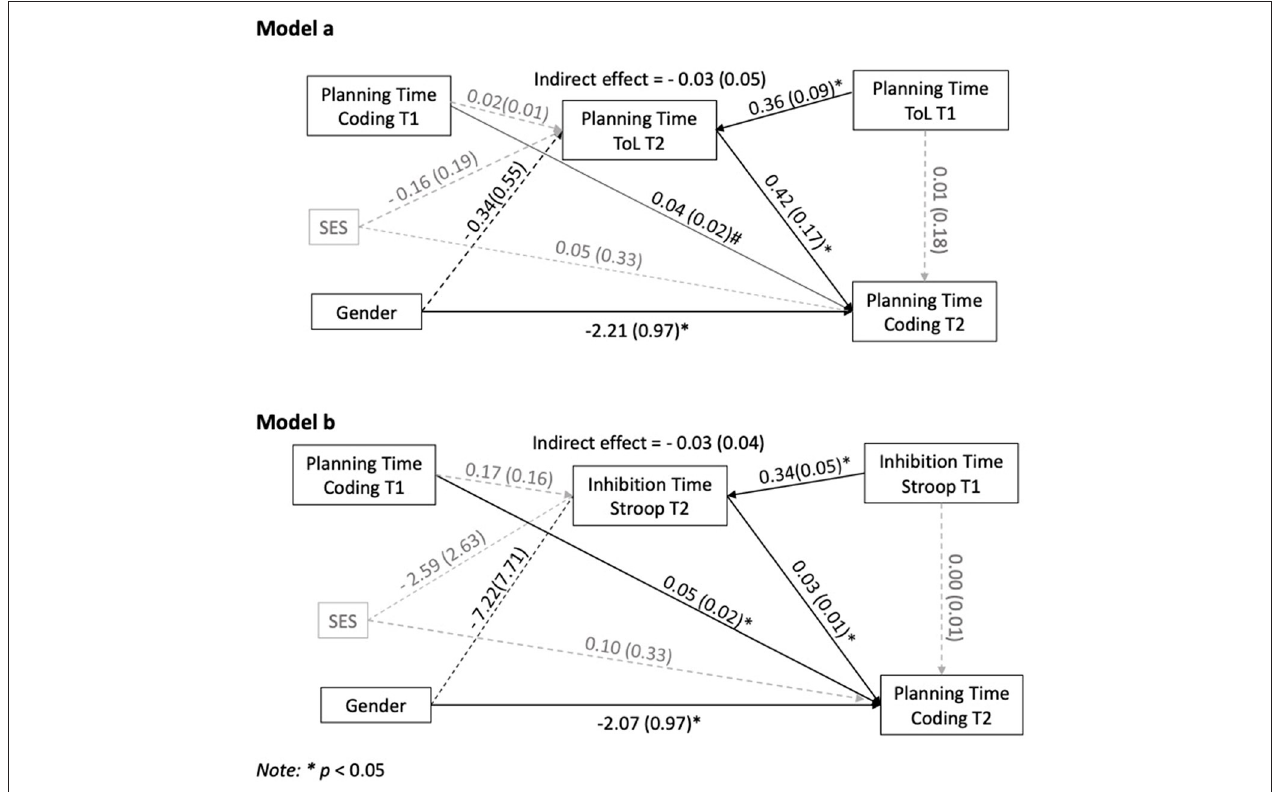
FIGURE 2 | Mediation models. Gender effects on coding planning time. * p <